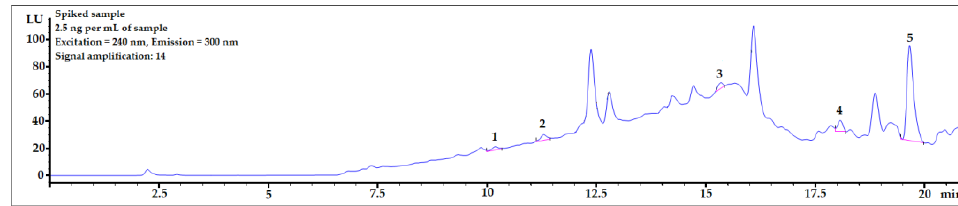
Figure 5. Amniotic fluid sample spiked with 2.5 ng per mL of sample. 1 — BPF, 2 — BPE, 3 — BPAF, 4 — BADGE∙2HCl, 5 — BPP . 4—BADGE · 2HCl,